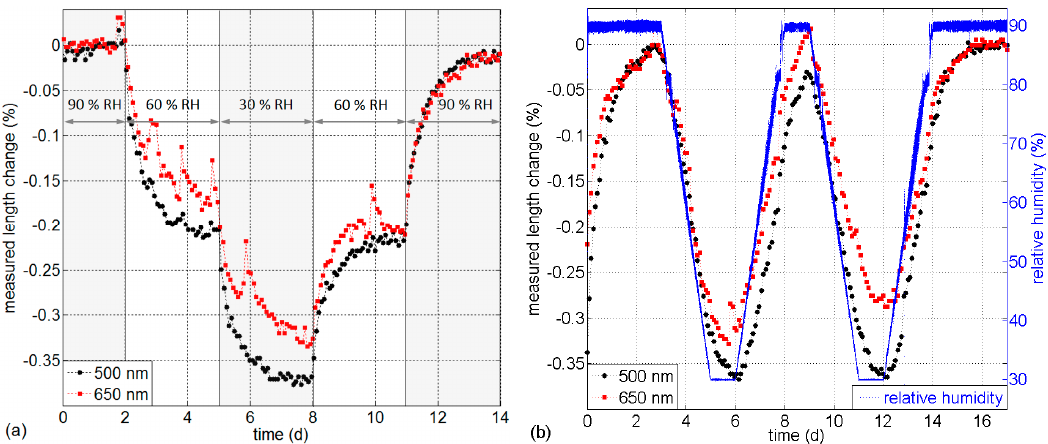
Figure 8. Measured length changes in % for 500 nm and 650 nm during ( a ) step-wise RH change and ( b ) gradual RH change.